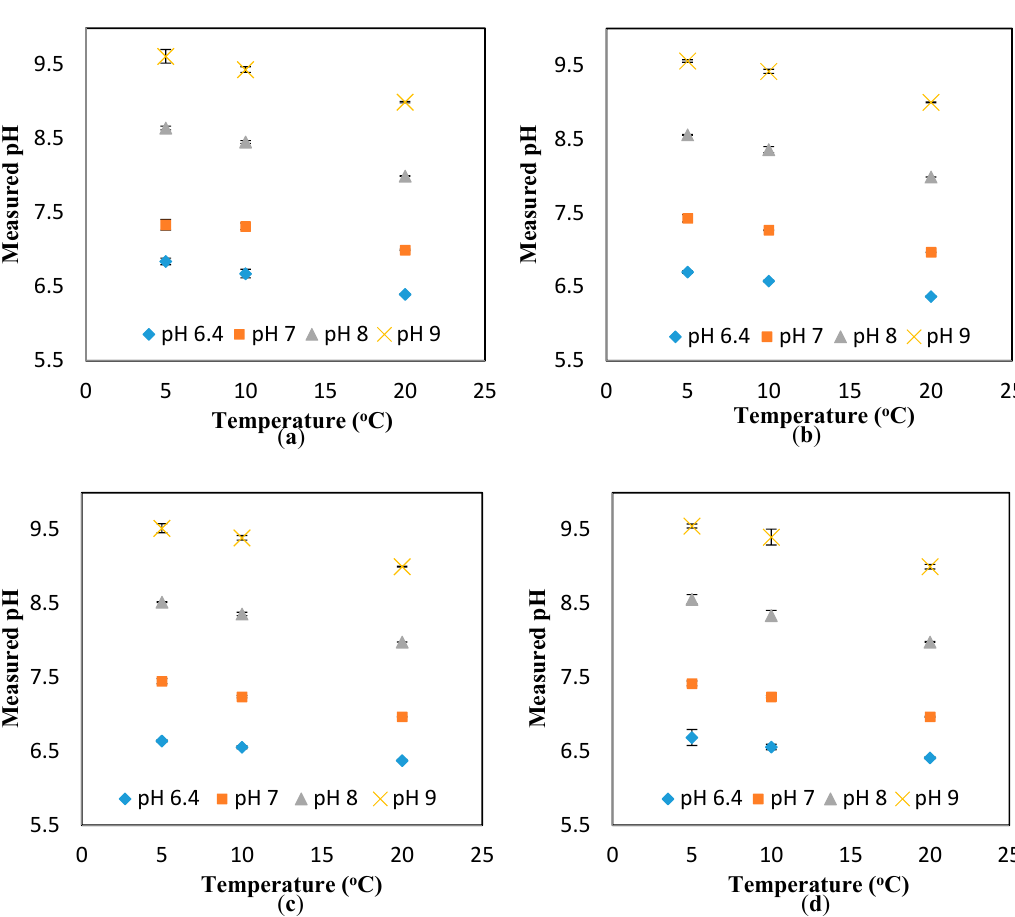
Figure A4. Effect of temperature on the response of the pH sensor compared to the theoretical values (both experimental and theoretical values were obtained at the static condition).